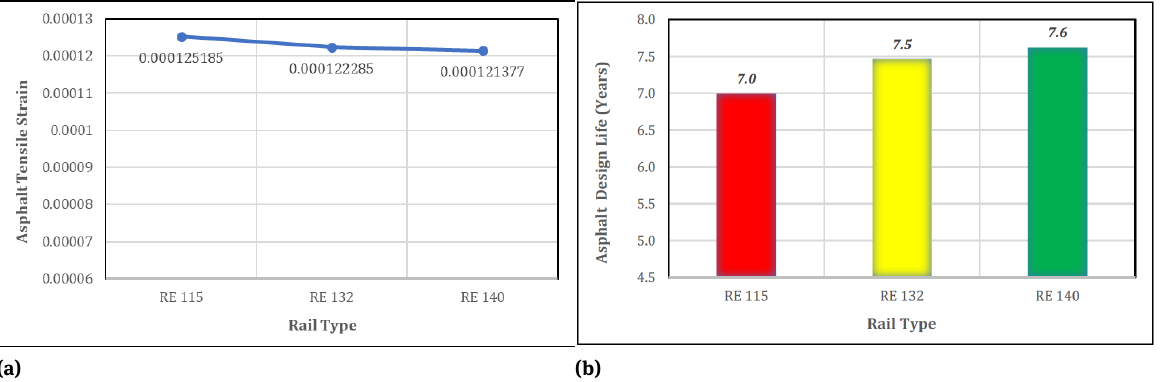
Figure 11: a) Effect of rail type on asphalt tensile strain; b) effect of rail type on asphalt design life in the asphaltic overlayment rail track.